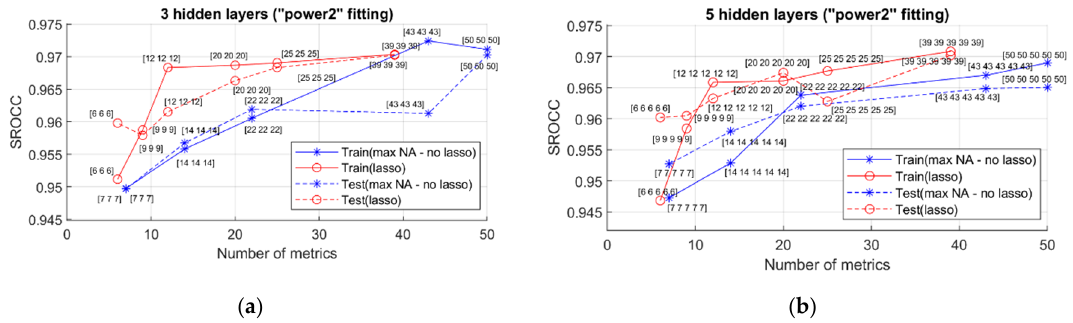
Figure 7. SROCC values for NNs with equal numbers of neurons in hidden layers for PFF with: ( a ) three layers; ( b ) five layers.